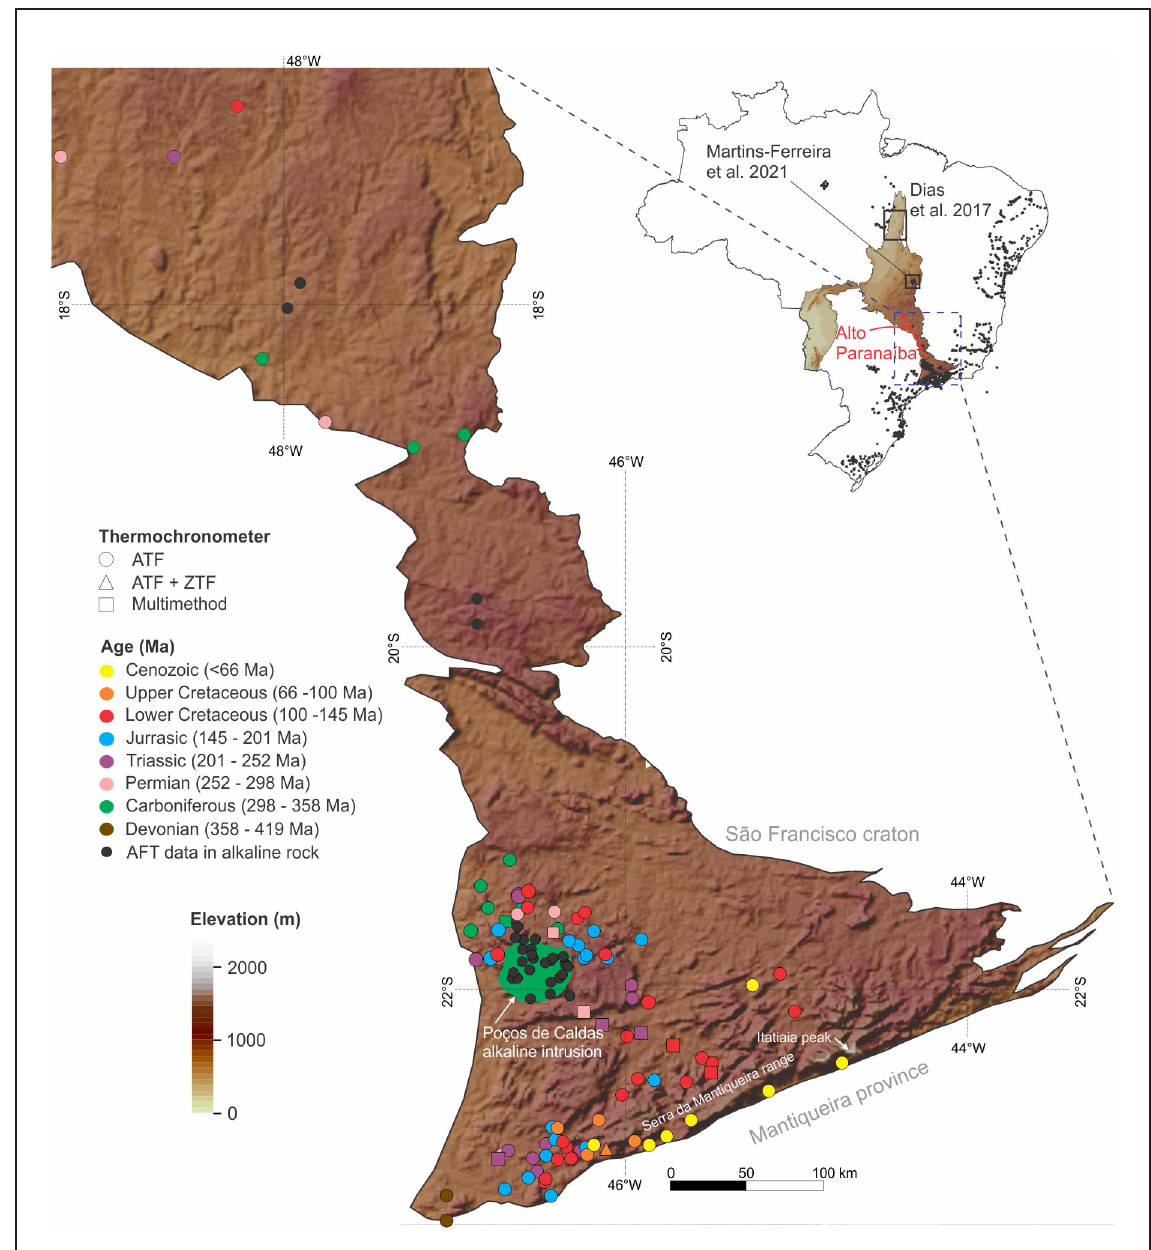
FIGURE 6 . Thermochronological data set published in the Tocantins province. In the Brazil map, the study of Dias et al. 2017 is highlighted. In the bottom, the southern portion of the Brasília belt where thermochronological data are concentrated. Poços de Caldas alkaline intrusion is drawn in green and the analyses from its rocks in black; The data of the Poços de Caldas alkaline intrusion is shown in the “Alkaline provinces”